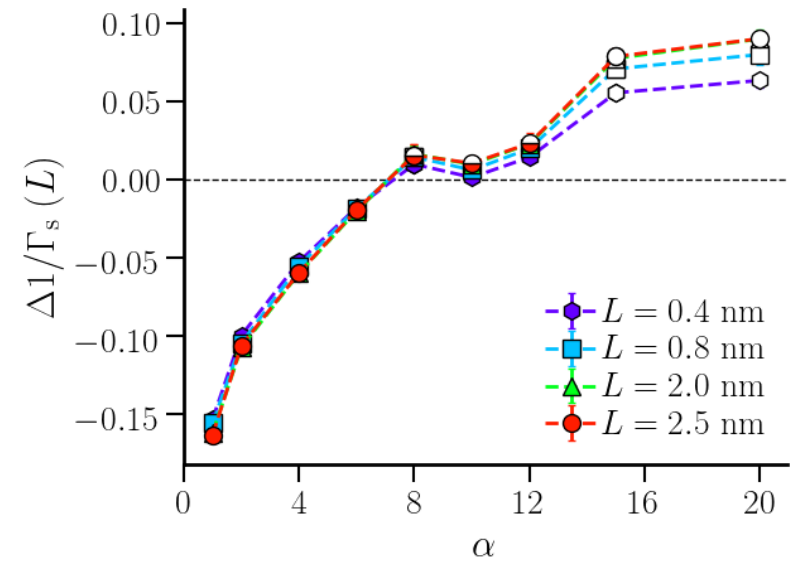
Figure 7. ∆ 1/ Γ s ( L )(= 1/ Γ s ( L ) − 1/ Γ • s ( L )) profiles for finite-sized first hydration shells with heights L = 0.4, 0.8, 2.0, and 2.5 nm as a function of the strength α of the repulsive interaction. The data points are grouped based on their variation with α (as in Figure 6). The error bars are calculated over four distinct windows in the production trajectory. The lines are guide to the eyes.